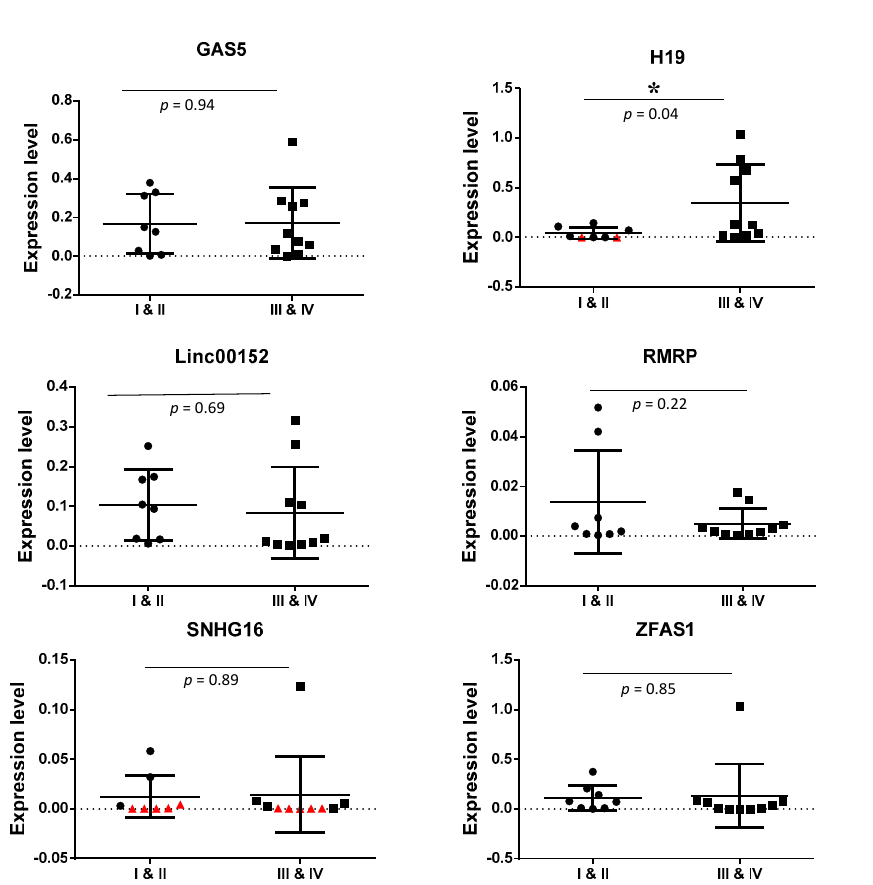
Figure 3. Comparison of lncRNAs expression level (2 ( − ∆ Ct) ) in serum exosomes from early (I and II) and advanced (III and IV) stages of CRC patients. The levels of lncRNA expression have been normalized to the reference gene, B2M. Student’s t -test was used to compare the expression of six long non-coding RNAs between early-stages and advanced stages of CRC patients, * indicates p < 0.05. Samples that could not be amplified were plotted as red triangles.